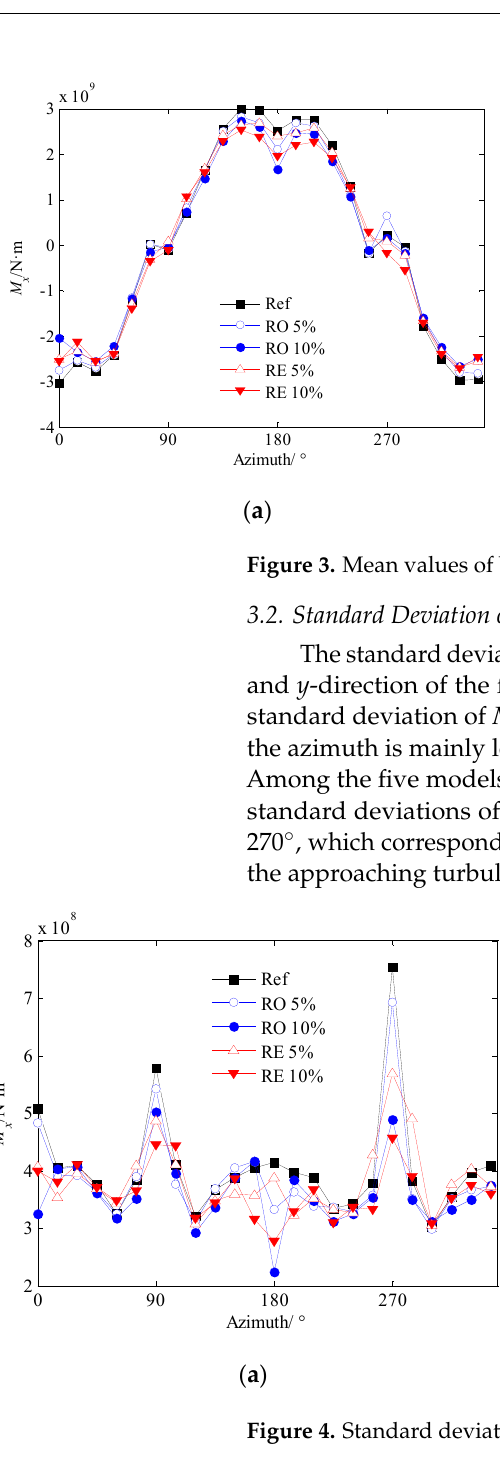
( b ) Figure 5. Moment spectra in critical azimuth: ( a ) S My at azimuth 0°. ( b ) S Mx at azimuth 270°. 4. Wind-Induced Response of the Building